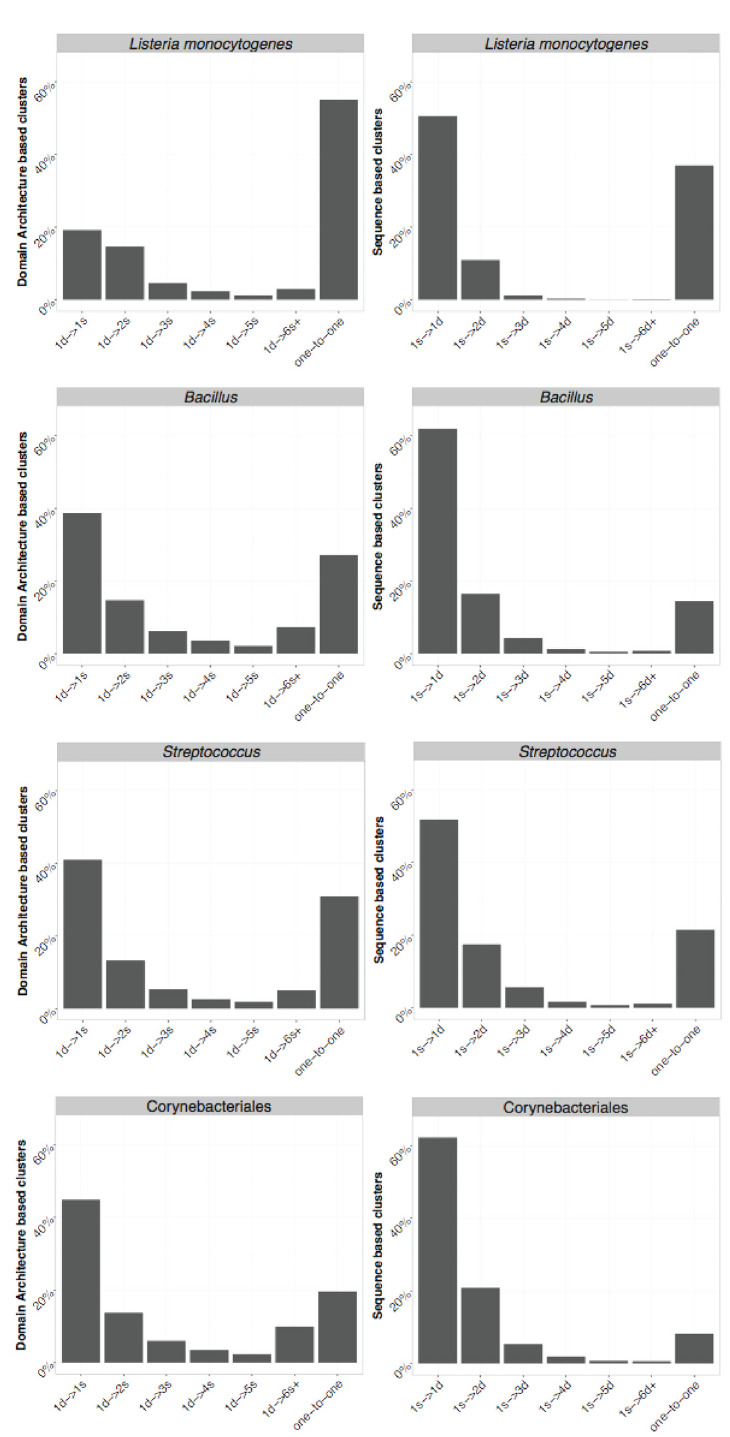
Figure 6. Comparison between DAB and SB clusters. On the left DAB is used as a reference and each bar represents the relative frequency of one DAB cluster containing sequences assigned to {1, 2, ... , 5} and 6 or more SB clusters and one-to-one represents the relative frequency of identical cluster. Similarly, on the right SB is used as a reference. Axis labels follow notation in Figure 5.